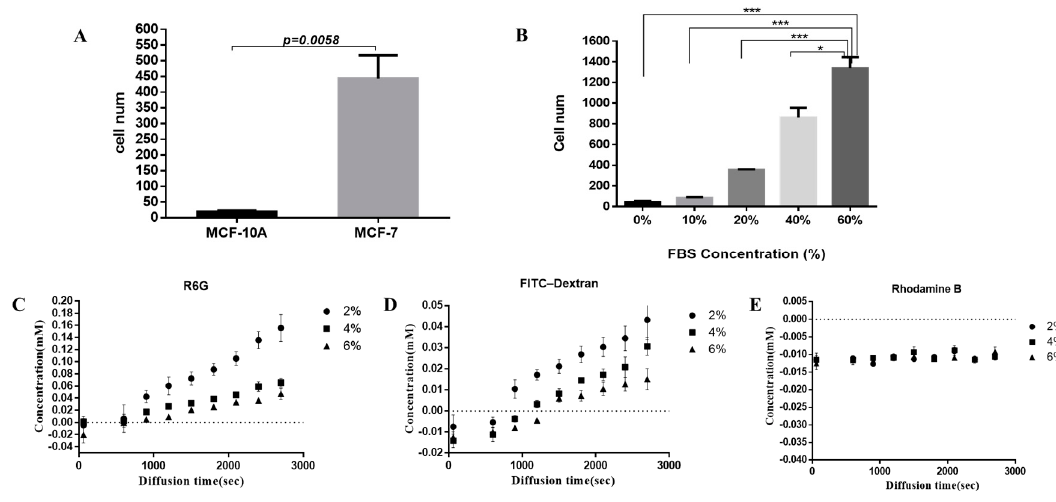
Figure 3. ( A ) The number of homing cells of MCF-10A and MCF-7 in 4% TAH. Values shown are mean ± SD of three independent experiments. p value = 0.0058. ( B )The number of MDA-MB-231 cells homing to TAH surface with different concentrations of fetal bovine serum (FBS). Experiments were performed in triplicate. A two-tailed unpaired ANOVA with Tukey’s HSD post hoc test. * p < 0.05, *** p < 0.001. ( C – E ) The permeability was measured of R6G, FITC-Dextran and Rhodamine B in 2 to 6% ( w/v ) TAH. The diffusion rate was determined by dynamic measuring of concentrations of tested substance at different time from 0 to 2800 s.